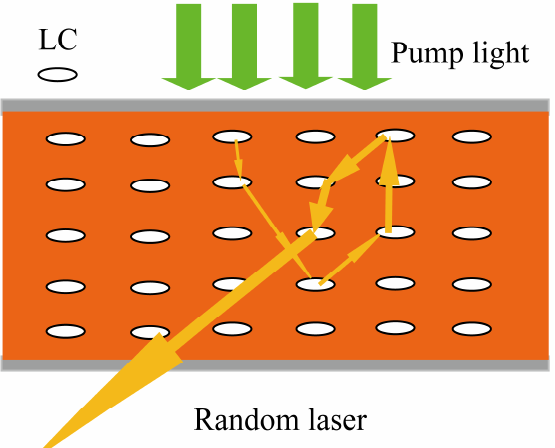
Figure 4. Multiple scattering of light caused by liquid crystal molecules in the gaining medium, green arrows: pump light, white circles: liquid crystal molecules, yellow arrows: path of light.